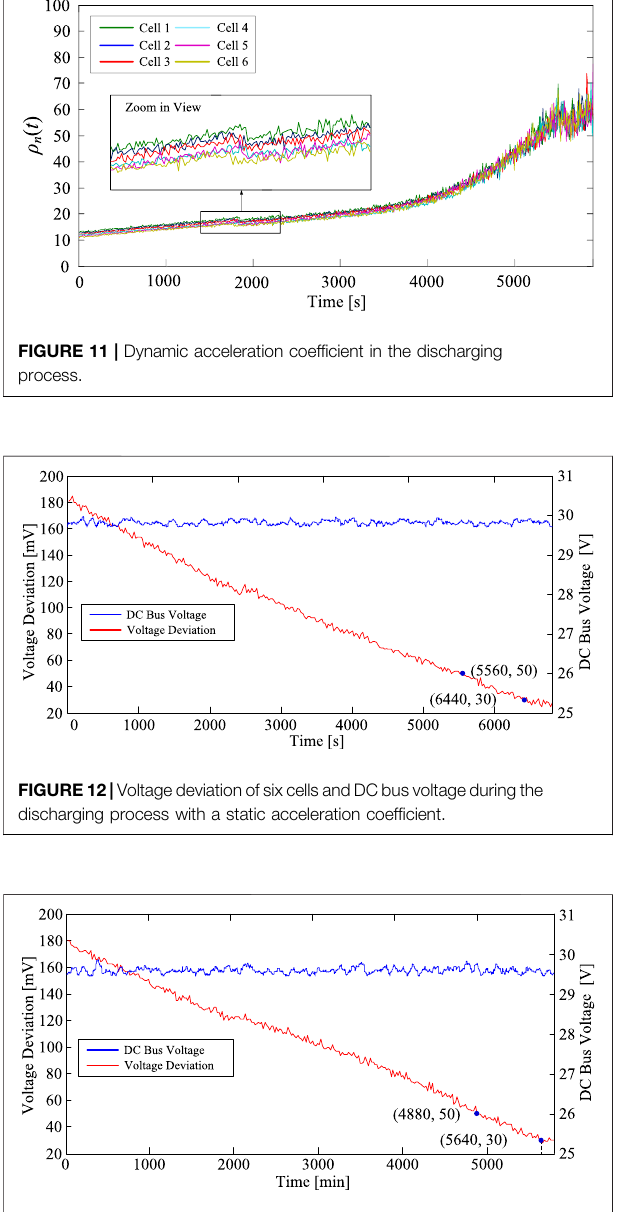
FIGURE13| VoltagedeviationofsixcellsandDCbusvoltageduringthe discharging process with a dynamic acceleration coef fi cient adaptive